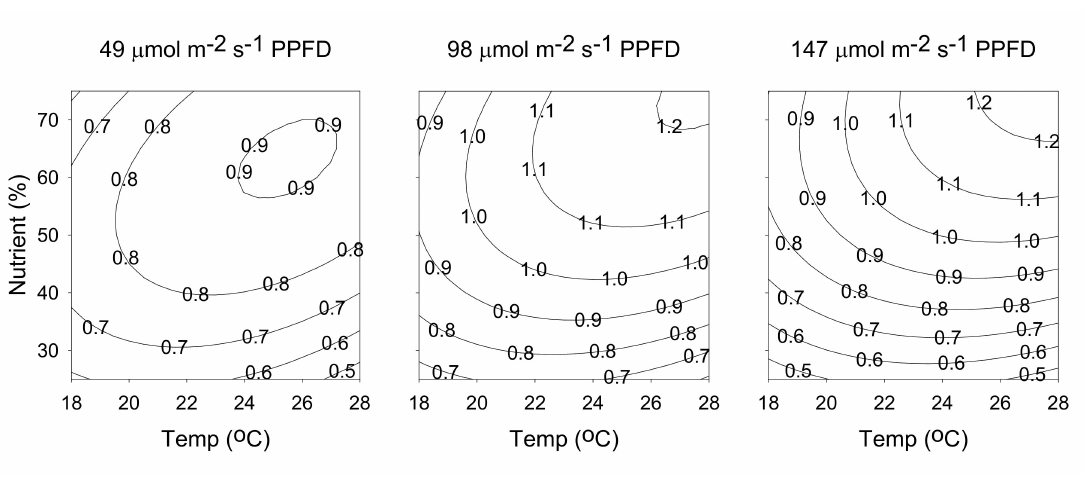
Figure 8. Contour plots of production yield of leaf biomass. The numbers inside the contour plots indicate production yield (g / plant) at given cultivated conditions.